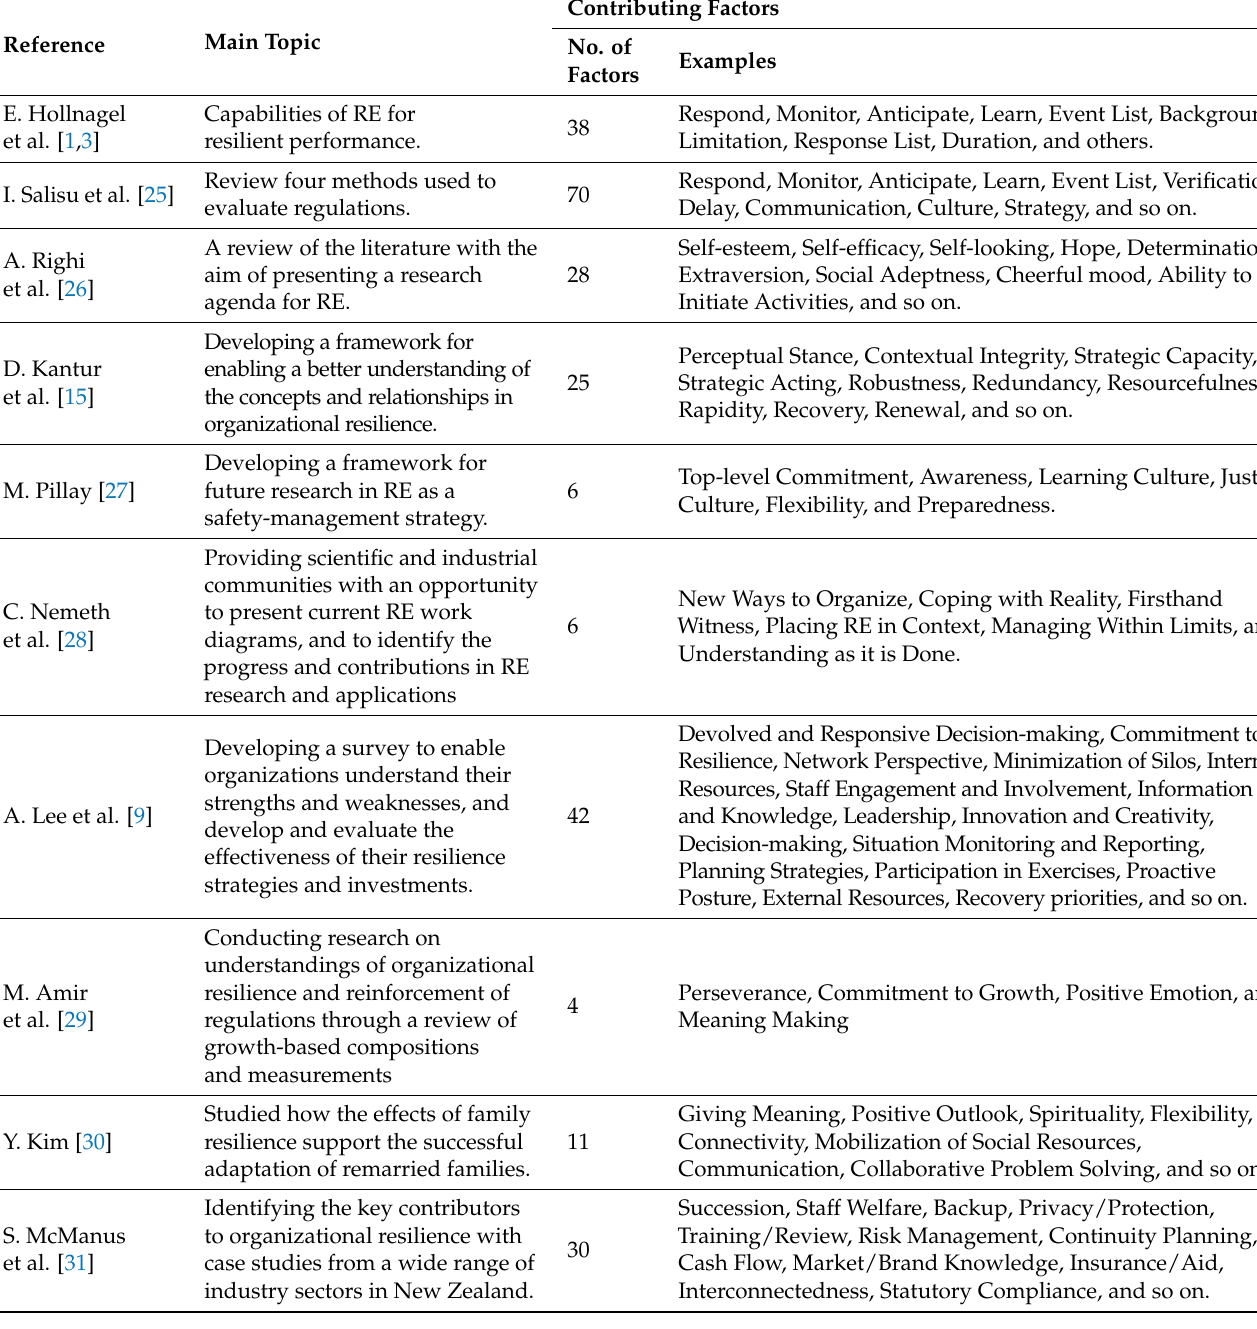
Table 1. Summary of identified contributing factors from the general